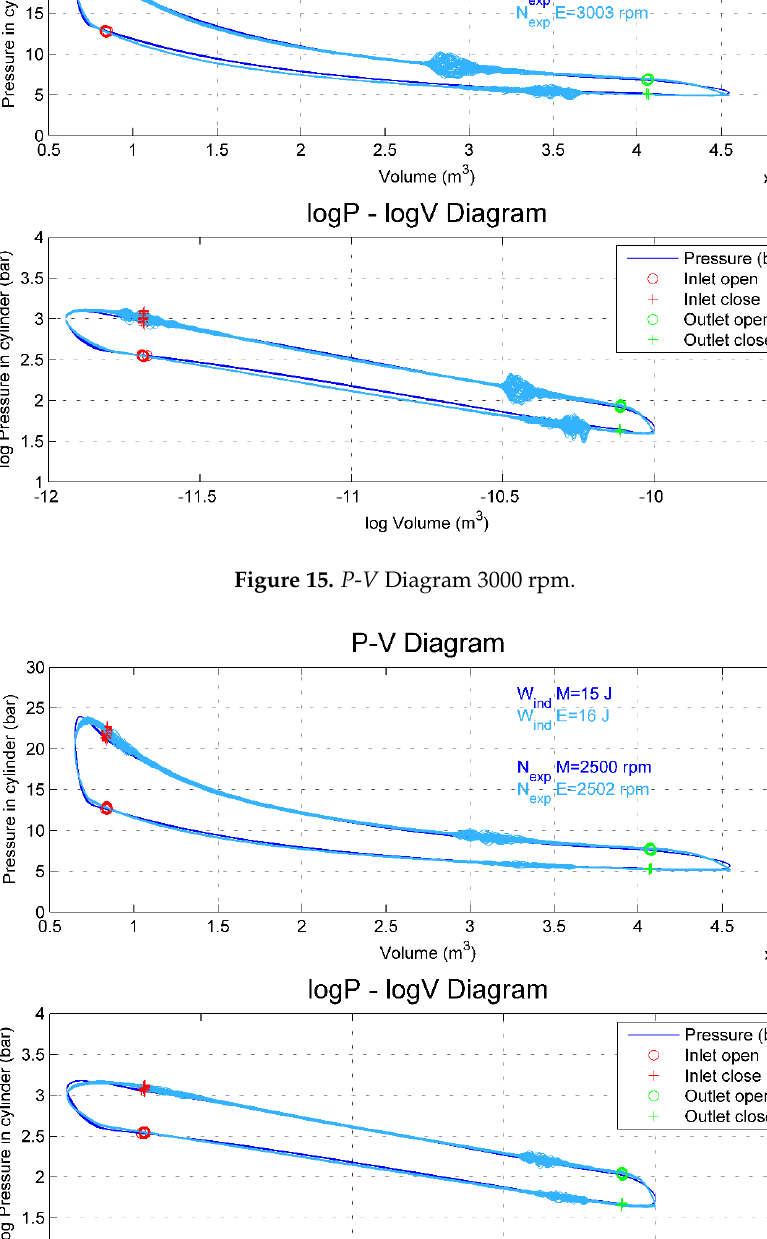
Figure 16. P - V Diagram 2500 rpm.